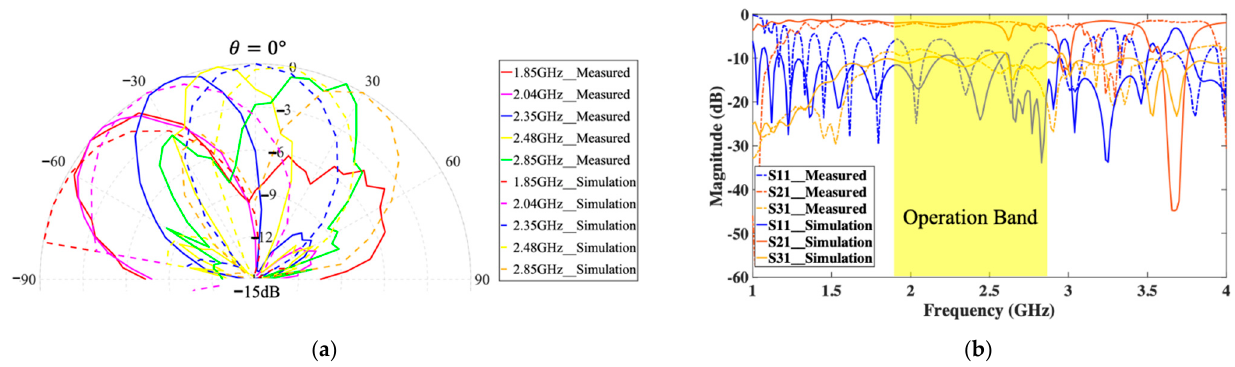
Figure 15. ( a ) Radiation pattern of 1-D MTM LWA at 2.4 GHz; ( b ) its S-parameters